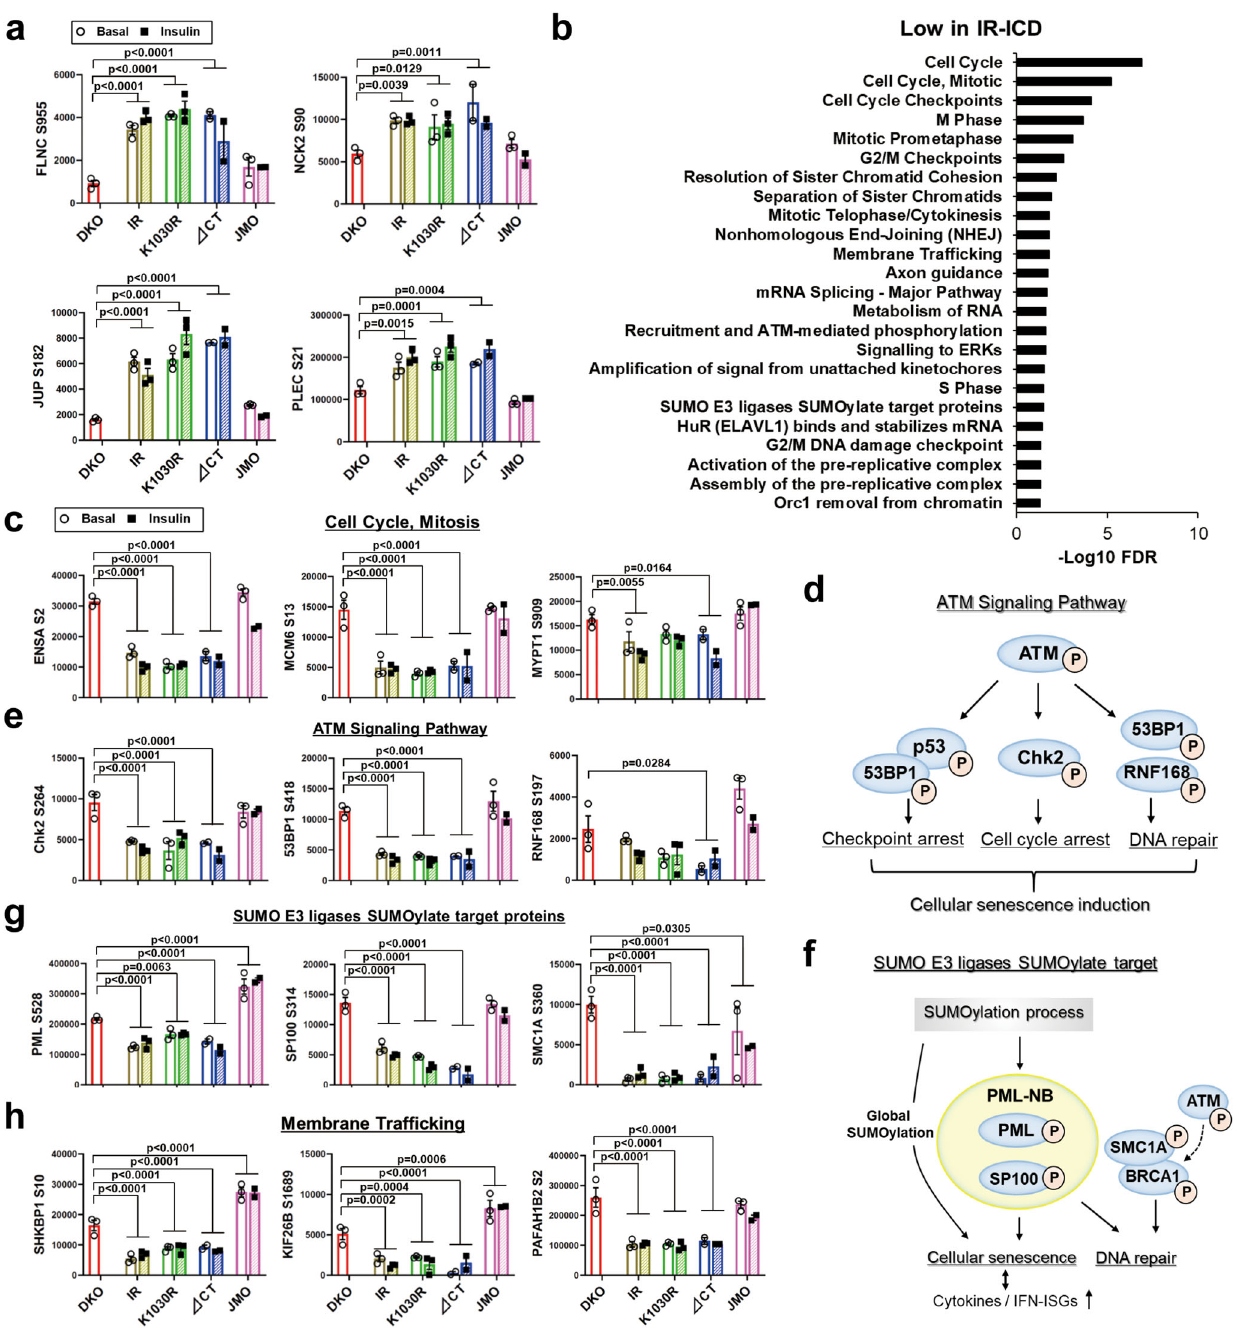
Fig. 3| Phosphorylationsignaturesareindependent ofkinaseactivitybyDKO, IR,K1030R, Δ CT,and JMOcells.a Quantitationof exemplaryphosphositesinthe enriched pathways (in Supplementary Fig. 3a) in the High-Phos in IR-ICD cluster. b REACTOME pathway enrichment analysis of phosphosites in the Low-Phos in IR- ICDcluster.ThefunctionalenrichmentanalysiswastestedbytheSTRINGdatabase, where FDRs were calculated using the Benjamini – Hochberg procedure. c Quanti fi cation of exemplary phosphosites of Cell Cycle and Mitosis pathway in the Low-Phos in IR-ICD cluster. d , e Representation of the ATM signaling pathway